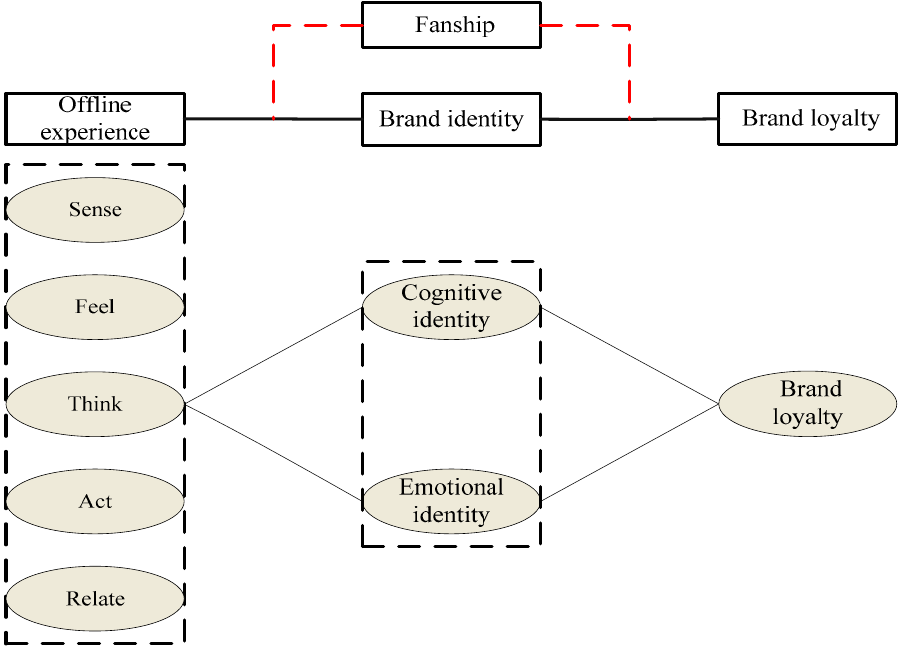
Figure 1. Research concept